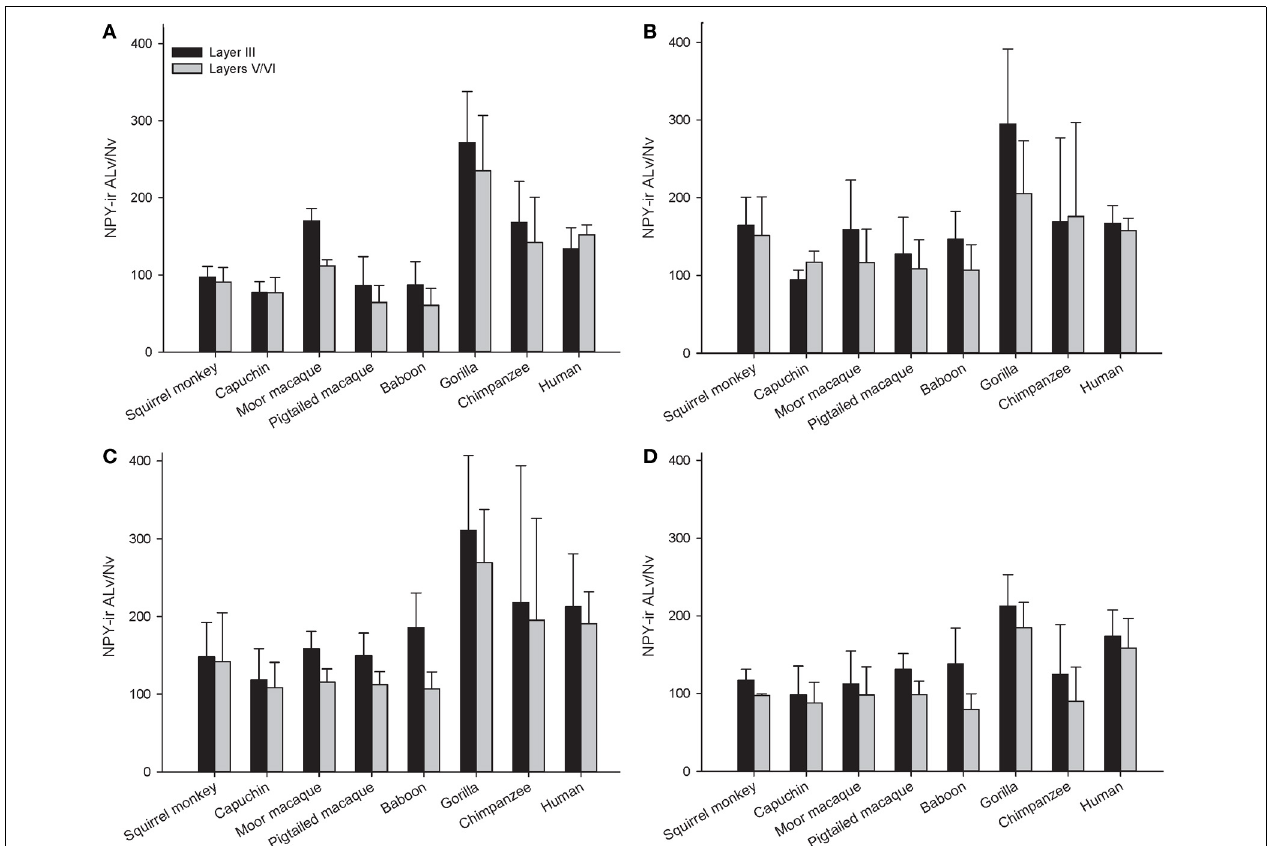
FIGURE 5 | NPY-irALv/Nv for each species for (A) area 10,(B) area 24, (C) area 44, and (D) area 22. Means are shown by bars. Error bars indicate standard deviation.